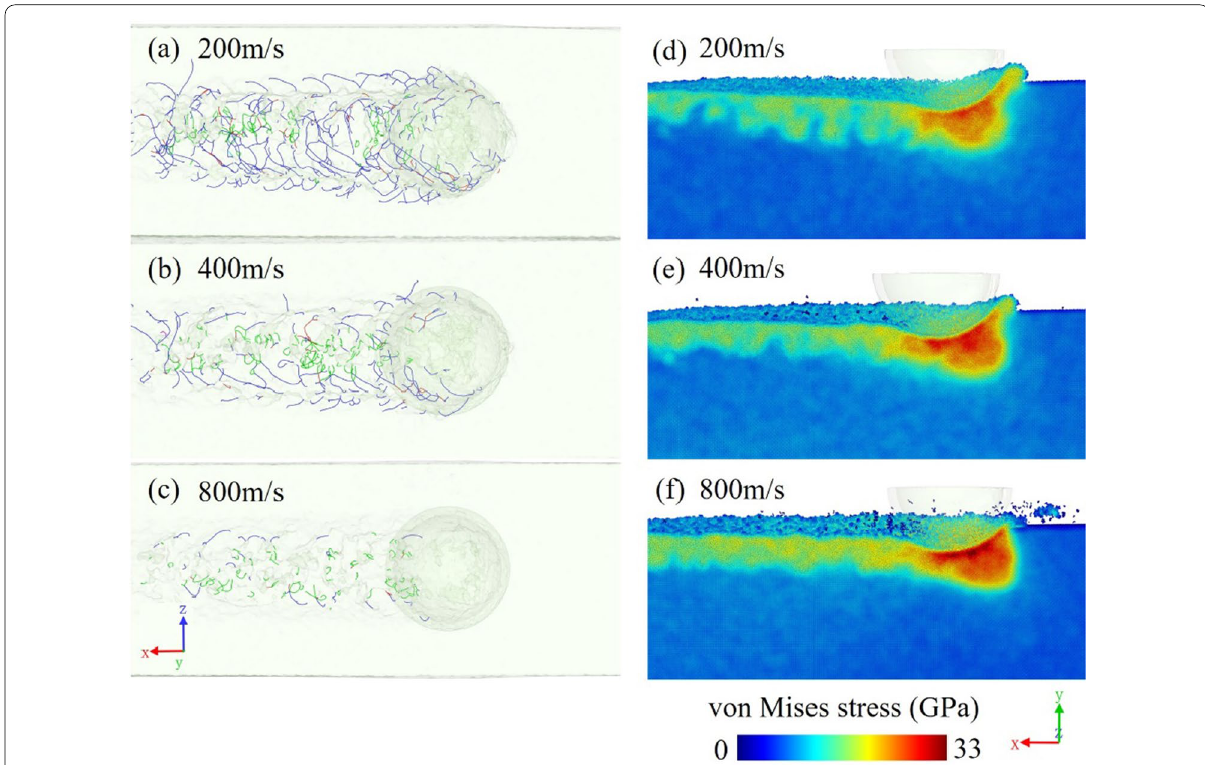
Fig. 11 Perspective views of dislocation distribution and von Mises stress distributions in models with different cutting speeds of a , d 200 m/s, b , e 400 m/s, and c , f 800